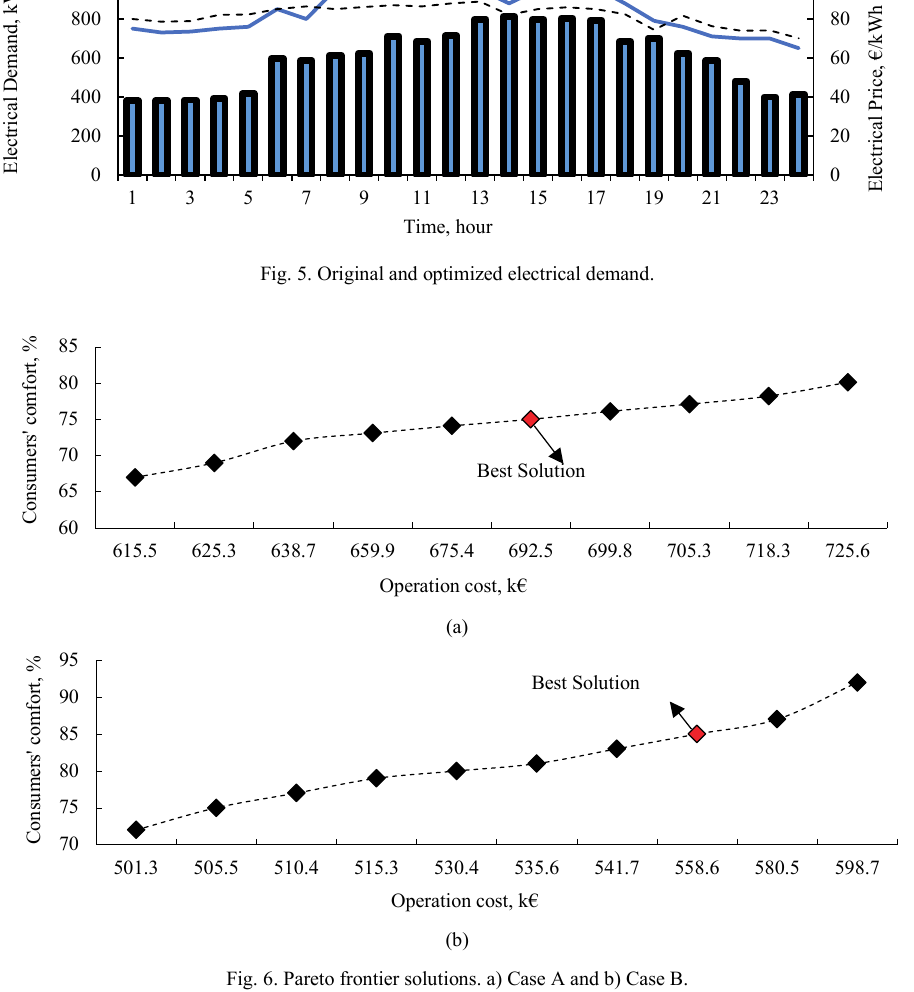
Fig. 6. Pareto frontier solutions. a) Case A and b) Case